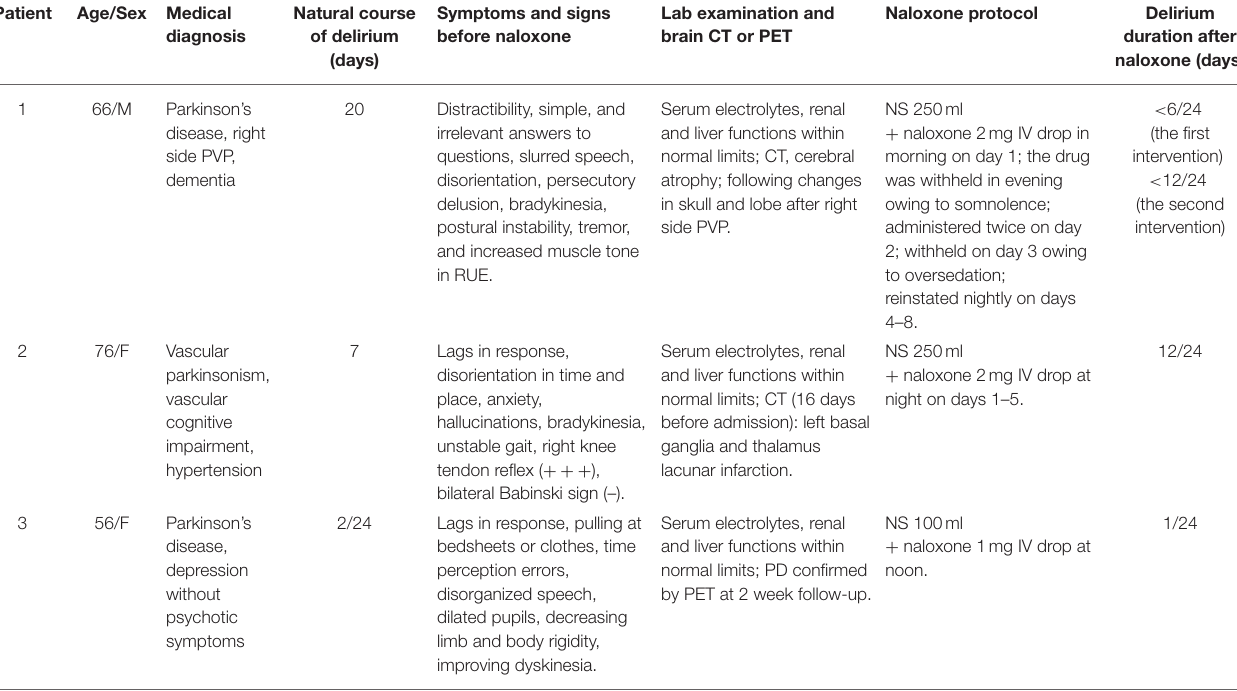
TABLE 1 | Patients’ demographics, clinical profile, and naloxone usage. Patient